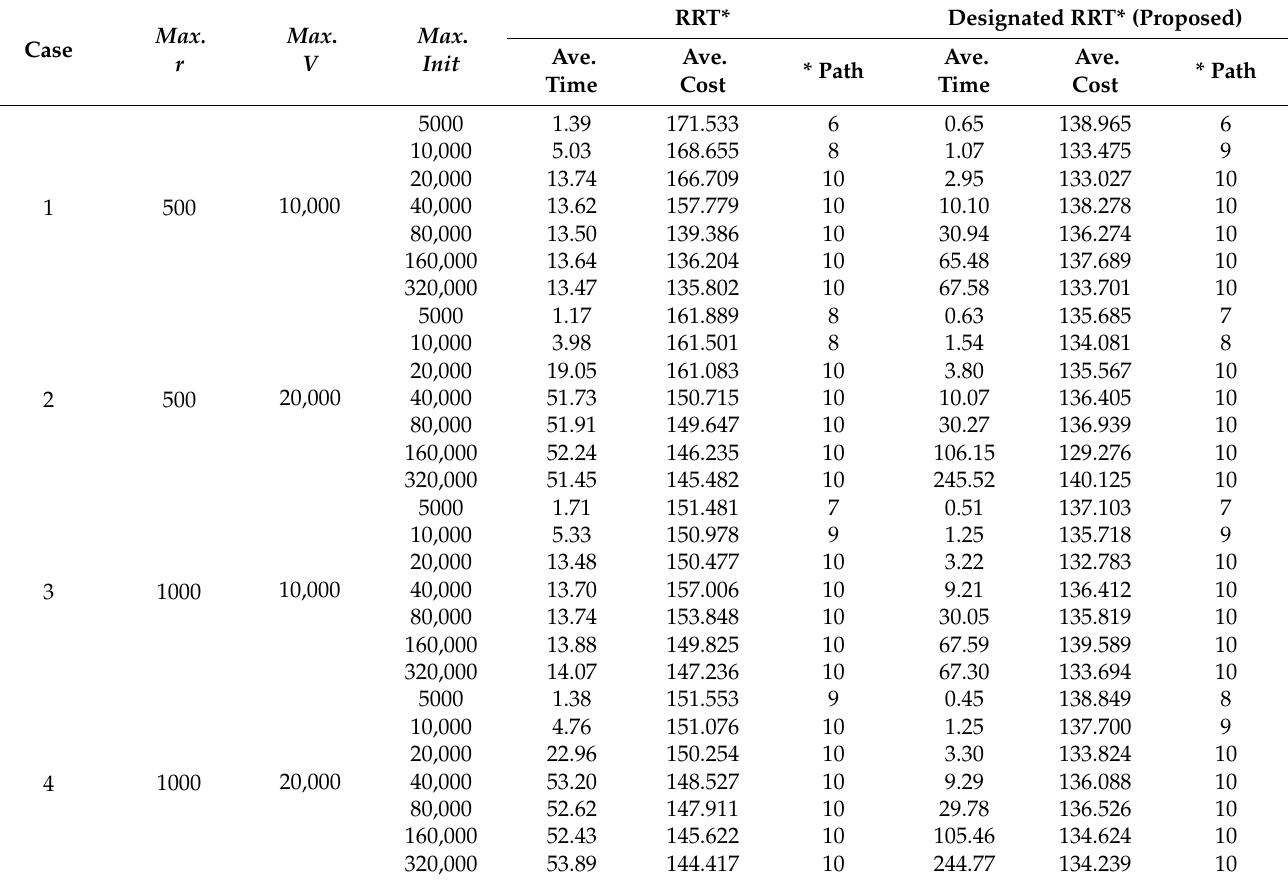
Table 5. Results of the simulations.